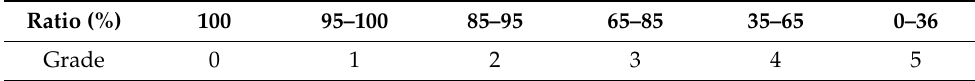
Table 3. Grades of GB/T9286-1998 color paint and paint film grid test.